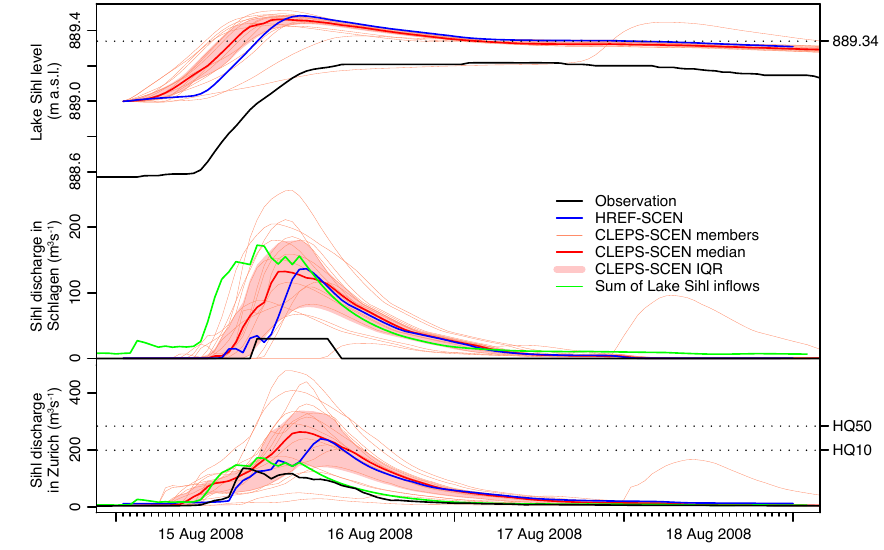
Fig. 11. As in Fig. 10, but for an artificially increased Lake Sihl level of 889ma.s.l. on 15 August 2008 at 00:00UTC.